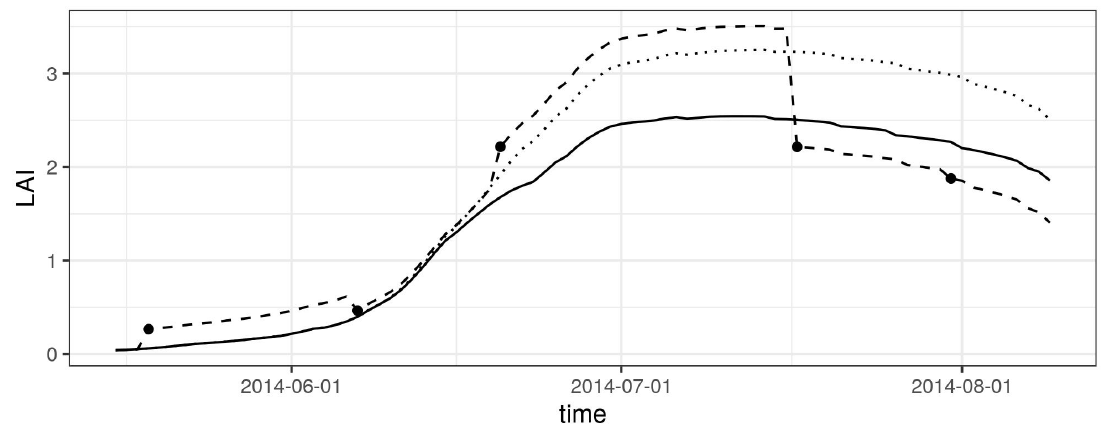
Figure 4. Open-loop simulation, direct insertion (DI) and least square estimator (LSE) illustrated on a plot of this study. Daily LAI values from observations (dots), open-loop (dotted line), DI (dashed line) and LSE (solid line) are plotted from the sowing day to the day of